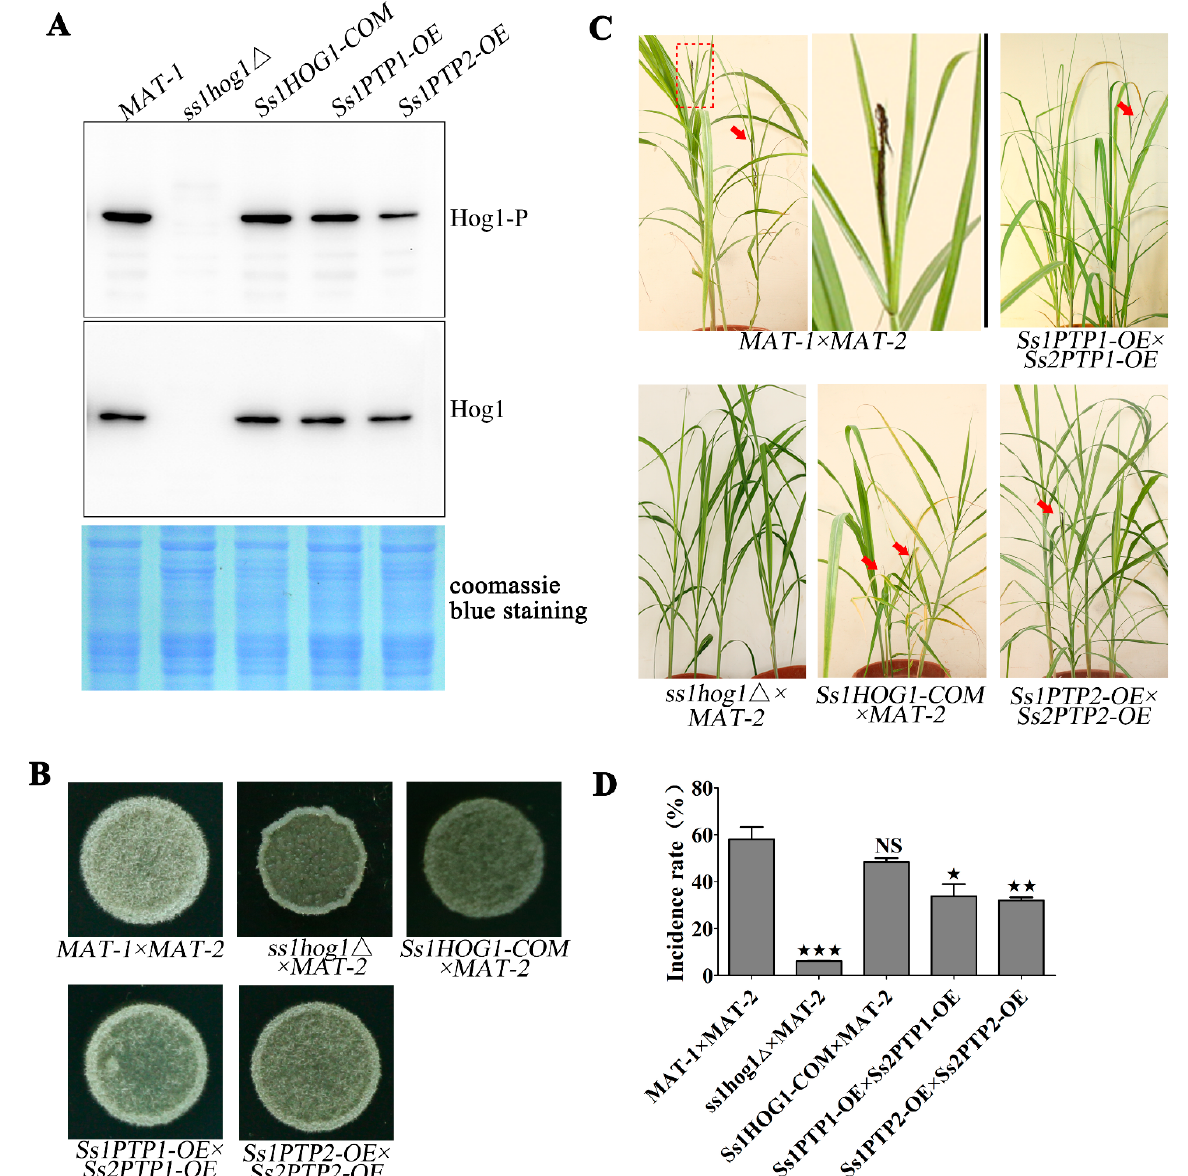
Figure 4. The effect of reduced SsHog1 phosphorylation level on mating and virulence. ( A ) Detection of SsHog1 phosphorylation in S. scitamineum . The fresh haploid sporidia were grown in YePSA medium at 28 °C for 30 h. The total protein of S. scitamineum was extracted with lysis buffer. Western blots depicting the levels of SsHog1 phosphorylation in the indicated strains. Above: blots were probed for phosphorylated SsHog1 (Hog1-P). Below: blots were probed for total SsHog1 (Hog1). Coomassie blue staining of total proteins served as loading control. ( B ) Mating assay of mutants. The fresh haploid sporidia were grown up to O.D.600 = 1.0, and then mixed with an equal volume of WT or mutant sporidia of opposite mating types and spotted onto YePSA medium to incubate at 28 °C. Images were taken after 30 h of cultivation. ( C ) Pathogenicity assay of mutants. MAT-1 × MAT-2 , Ss1PTP1-OE × Ss2PTP1-OE , Ss1PTP2-OE × Ss2PTP2-OE , Ss1HOG1-COM × MAT-2 and ss1hog1 Δ × MAT-2 combination were inoculated into the sugarcane seedlings of variety ROC22. The infection assays were performed with at least 15 seedlings. The symptoms of ‘black whip’ were documented and photographed at about six months post inoculation. The symptoms of ‘black whip’ are denoted by red arrows. The red dotted box regions were enlarged for a better view of whip symptoms. ( D ) Bar chart depicts the quantification of infection as shown in ( C ). Percentage (%) of ‘black whip’/total seedlings was indicated. Bar chart depicts the statistical difference among the mean values ( ★ p < 0.05, ★★ p < 0.01, ★★★ p < 0.001). Mean ± S.E. were derived from two independent biological repeats with three replications.